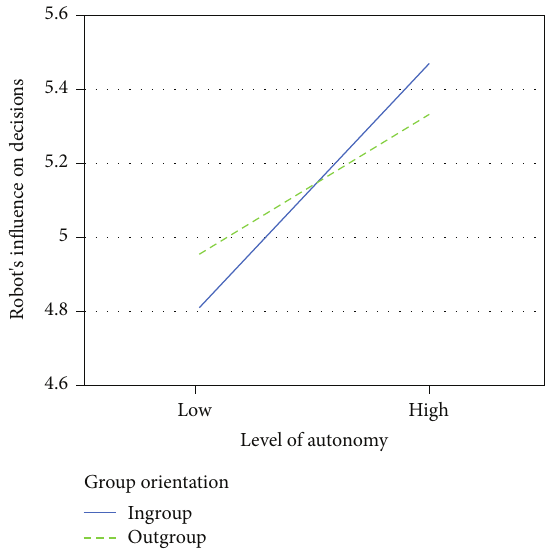
Figure 3: Interaction effect of autonomy and group orientation on robot’s influence on